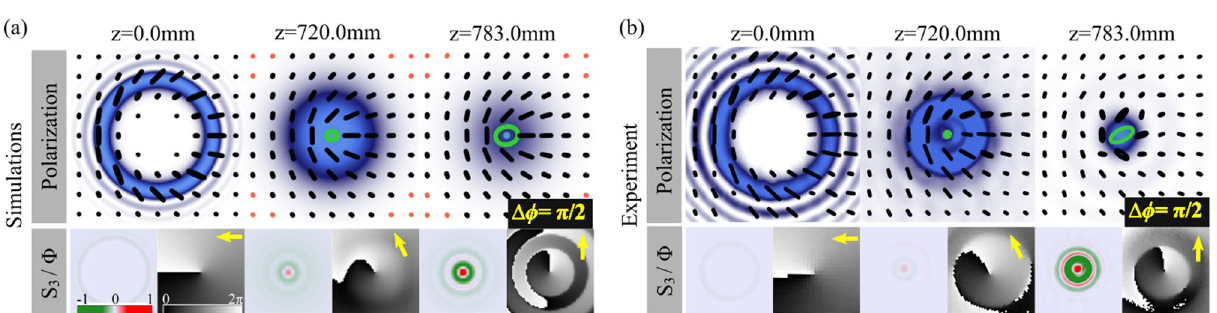
Figure 3. ( a ) Simulations and ( b ) experimental propagation dynamics of (cid:31) 1,0 modes. Top to bottom: intensity overlapped with polarization distribution and S 3 parameter (left) and the intramodal phase (cid:31) = S 1 + iS 2 (right). Such phase rotate an angle of Gouy phase �φ = π/ 2 , which is marked as yellow arrow in the inset. Noteworthy, we show the right and left polarization with orange and green ellipses, while the linear polarization black